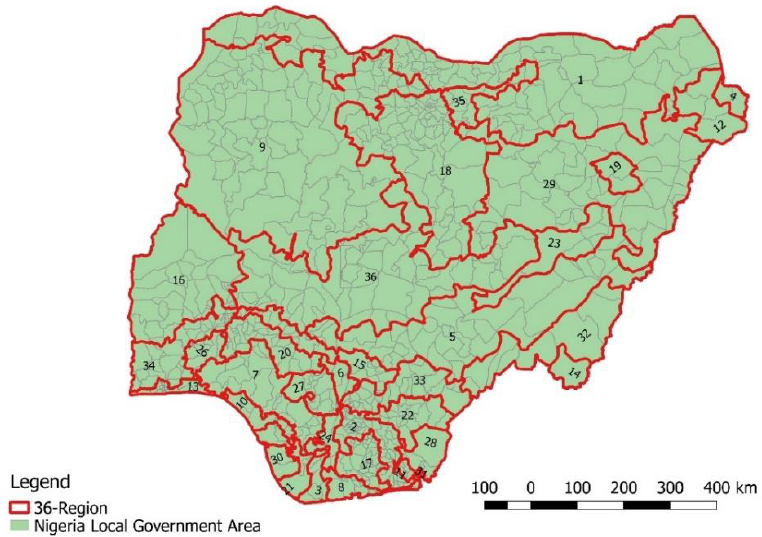
Figure 9. Thirty-six regions scenario for Nigeria developed using the “regionalization with dynamically constrained agglomerative clustering and partitioning” (REDCAP) technique.